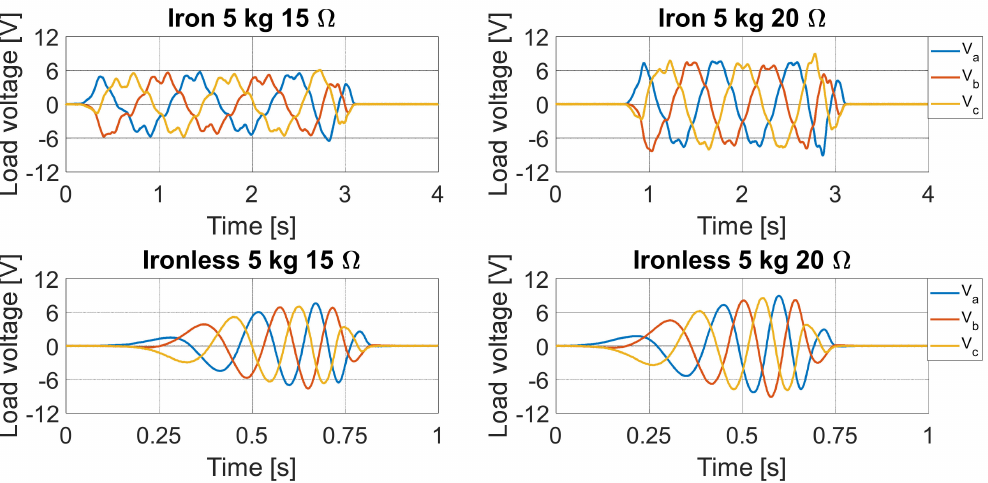
Figure 13. Load voltages trends of the 5 kg test with a resistance load equal to 15 Ω and 20 Ω .